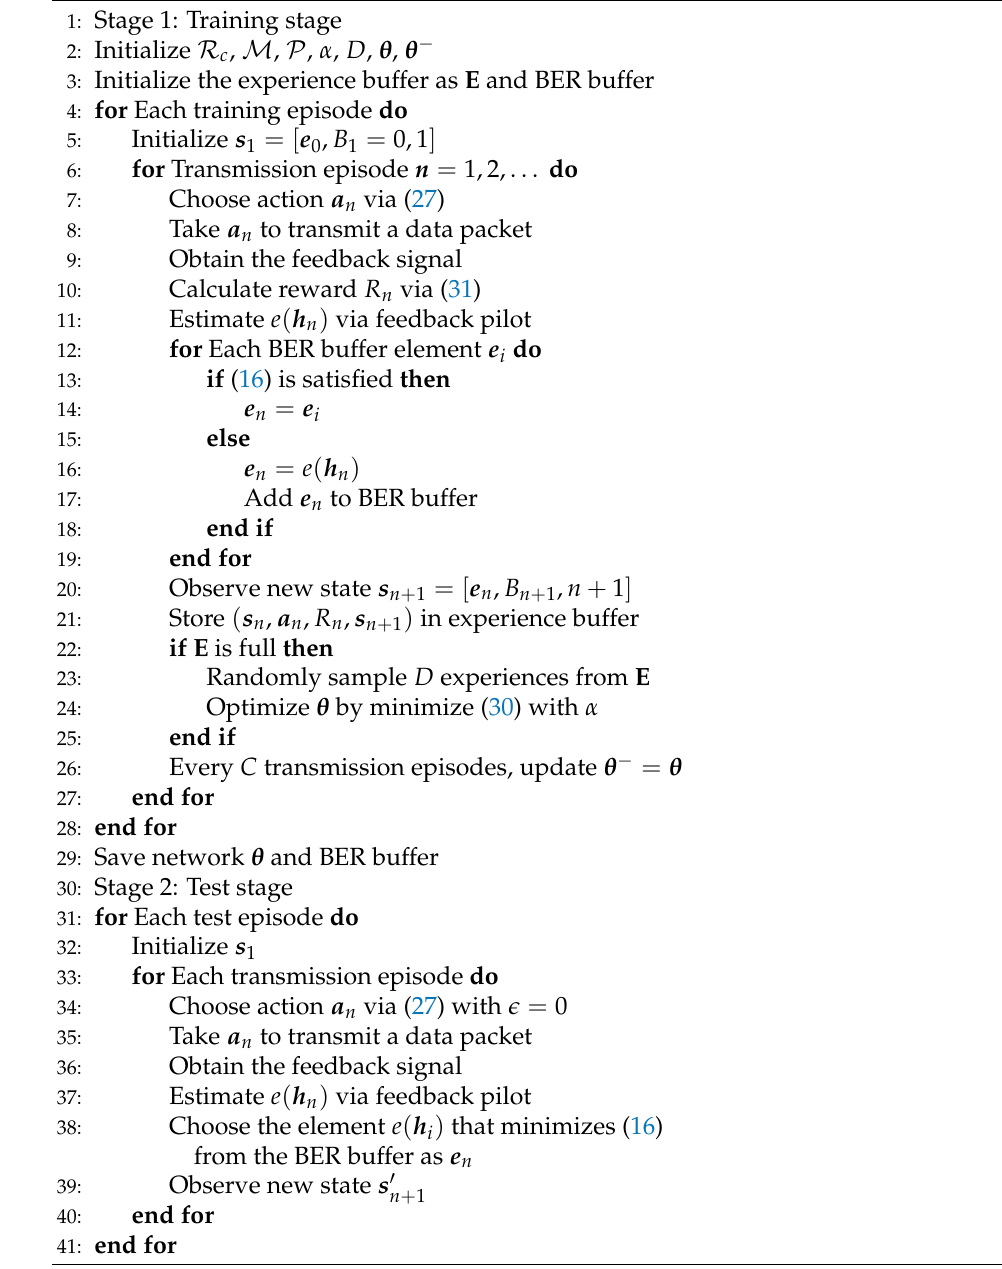
Algorithm 1 Proposed